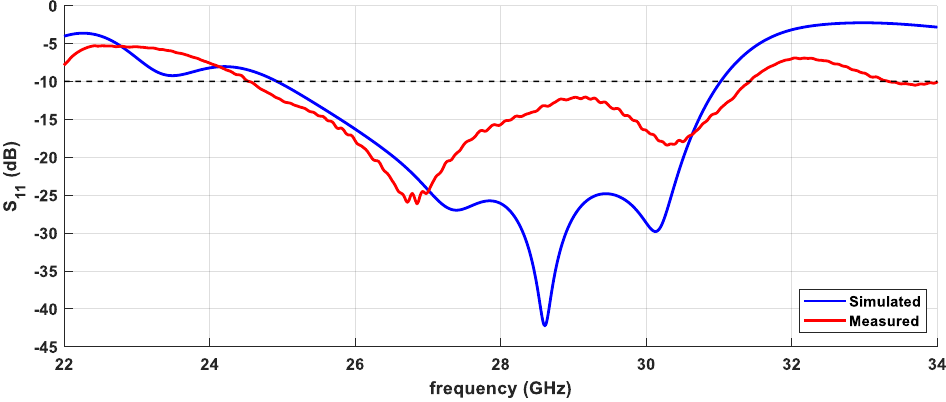
Figure 5. Simulated and measured reflection coefficient of the 5 elements antenna array.